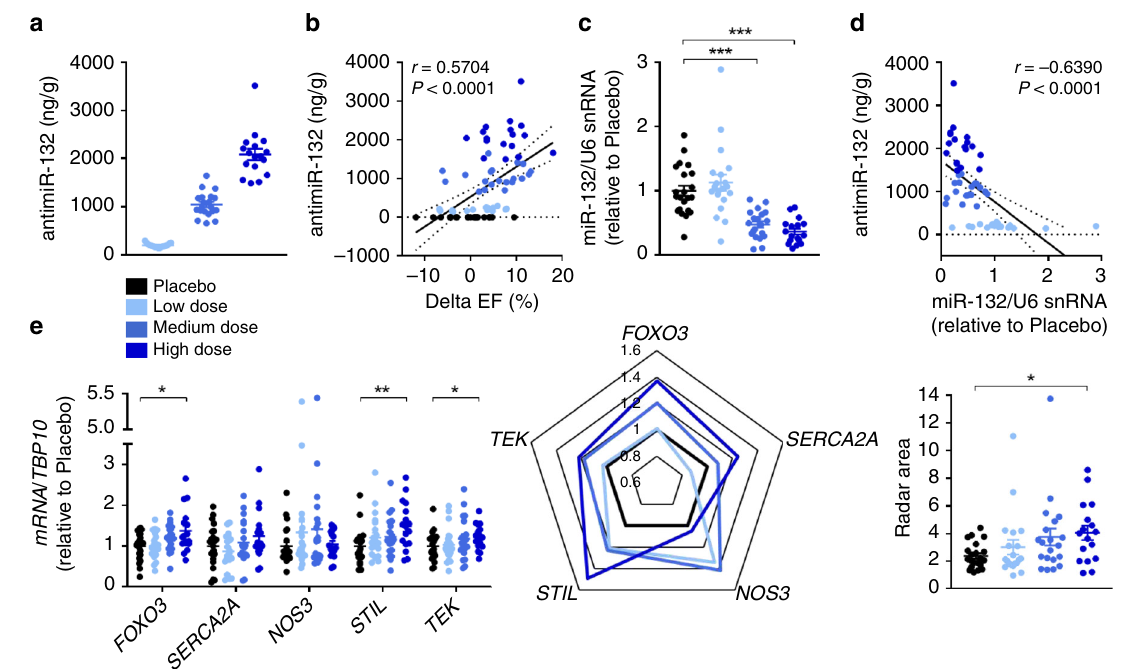
Fig. 5 PK/PD relationship and target engagement panel. a Tissue levels of antimiR-132 detected in the left ventricular (LV) remote region for different dosing groups of intracoronary/intravenous (ICIV) and intravenous/intravenous (IVIV) treated animals (Placebo: NaCl; Low = 1 mg/kg, Medium = 5 mg/ kg and High = 10 mg/kg antimiR-132). b Correlation between antimiR-132 tissue levels and functional improvement (delta ejection fraction (EF) = EF day 56 – EF day 3 ). c Functional tissue level of miR-132 detected in the LV remote region. d Correlation between antimiR-132 and miR-132 tissue levels. e Target de- repression in the LV remote region after antimiR-132 treatment (Forkhead Box Protein O3, FOXO3 ; Sarcoplasmic/Endoplasmic Reticulum Ca 2 + ATPase 2, SERCA2A ; Endothelial Nitric Oxide Synthase 3, NOS3 ; SCL/TAL1 Interrupting Locus, STIL ; TEK Receptor Tyrosine Kinase, TEK ). Radar chart depicting the target engagement panel. ICIV and IVIV: Placebo: n = 22, Low dose: n = 20, Medium dose: n = 20, High dose: n = 17. Data are mean ± s.e.m; * P < 0.05, ** P < 0.01, *** P < 0.001; Kruskal – Wallis test with Dunn ’ s multiple comparison and linear regression using non ‐ parametric Spearman